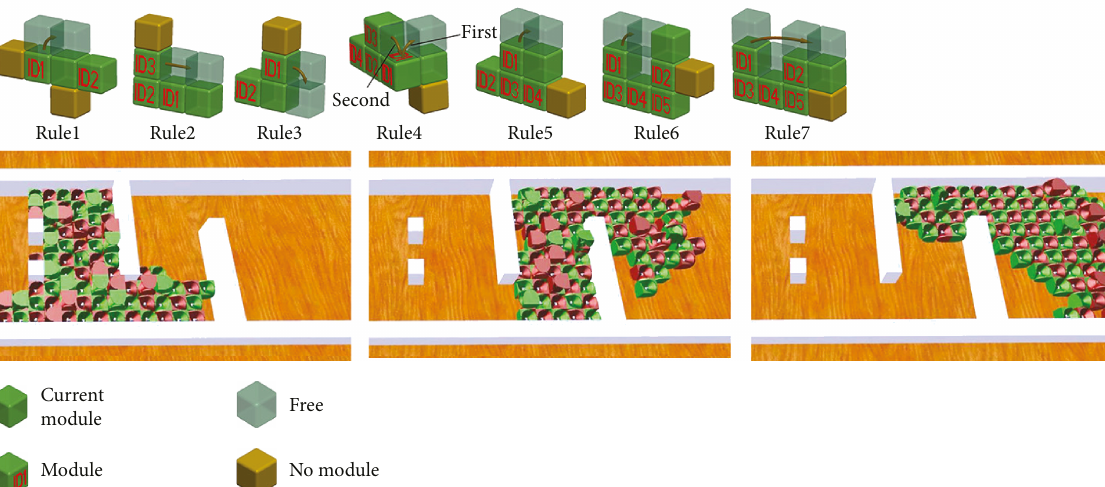
Figure 4: Surface locomotion of UBot robots controlled by CA.